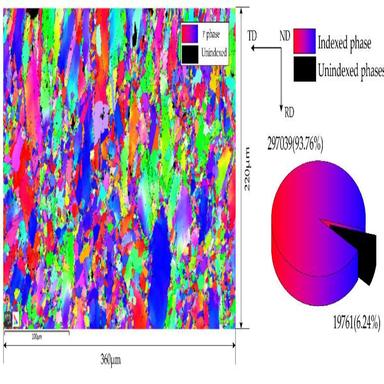
Acquired electron backscattered diffraction data.